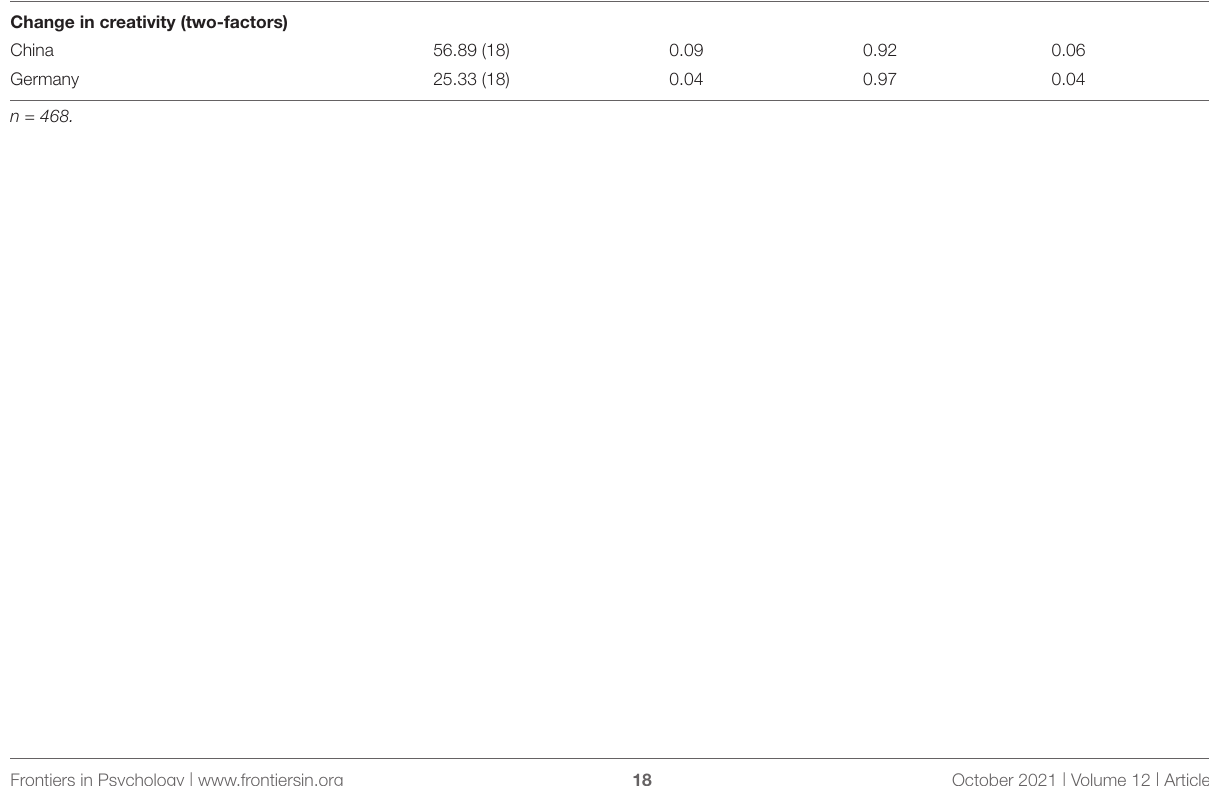
TABLE 3.2 | CFA results of the pooled sample of change in creativity before and during lockdown based on a split sample. Model χ 2 (df) RMSEA CFI SRMR